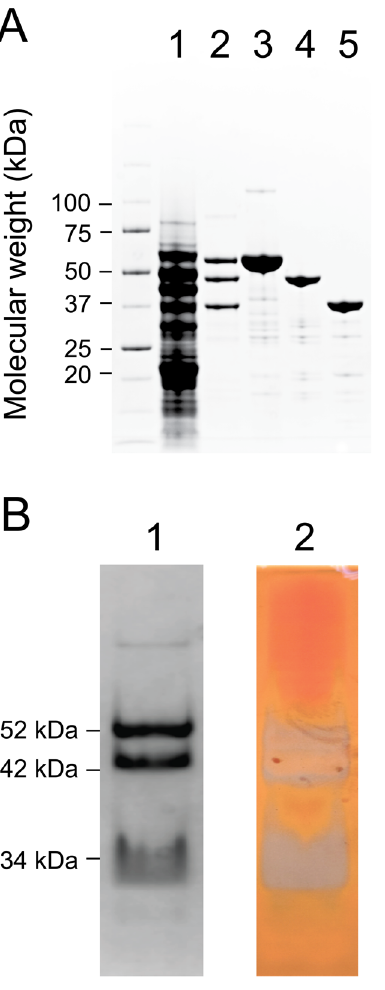
Figure 3. PAGE analysis of SACTE_2347 preparations. A, Lane 1, Streptomyces sp. SirexAA-E secretome; lane 2, fraction from the ion exchange separation that showed the maximal mannanase activity; lane 3, recombinant SACTE_2347_FL purified from E. coli BL21(DE3); lane 4, recombinant SACTE_2347_42kDa; lane 4 recombinant SAC- TE_2347_34kDa. B, in-gel determination of mannan-degrading activity. Lane 1, native PAGE with Coomassie Blue staining of the fraction from A, lane 2 performed with mannan included in the gel; lane 2, Congo Red staining of the gel. Regions of the gel that contain polysaccharide bind the dye and appear orange; regions of the gel containing enzyme activity no longer contain polysaccharide and so have a grey-colored appearance.